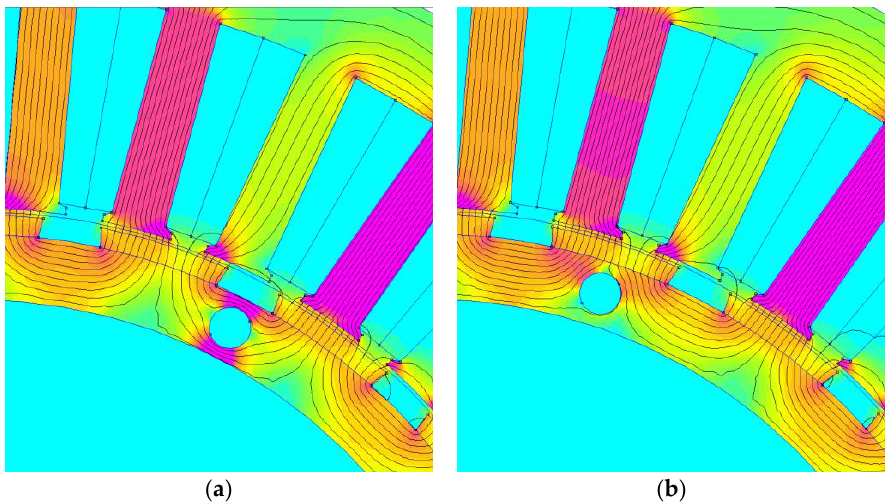
Figure 10. Magnetic field distribution ( θ = 0 ◦ ): ( a ) Original model, without centered holes; ( b ) Model with centered holes.